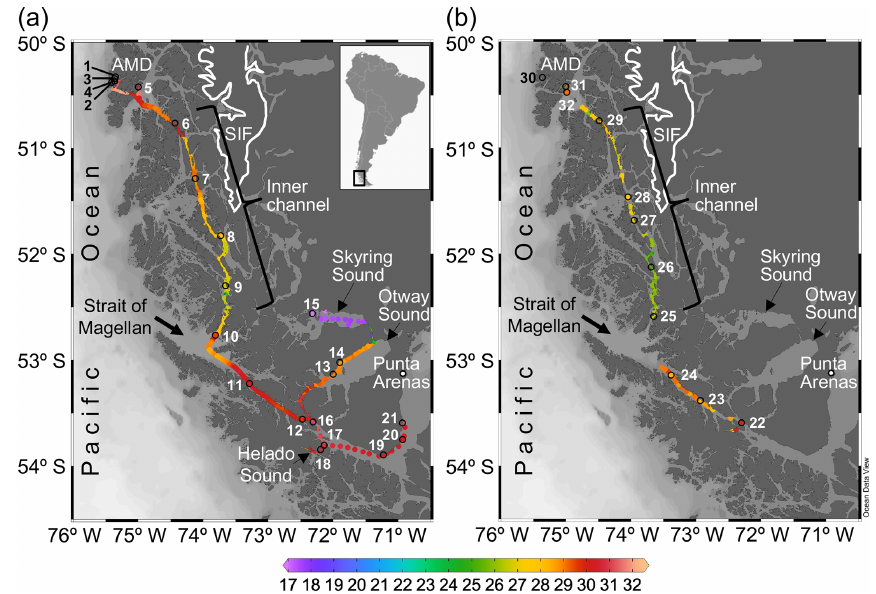
Figure 1. Maps of southern Patagonia showing the study sites and stations sampled during the austral late spring 2015 (a) and early spring 2017 (b) . Salinity recorded at the surface during the two cruises is plotted. The approximate perimeter of the Southern Ice Fields (SIF) is depicted. A zoom into the Archipelago Madre de Dios (AMD) zone with salinity and (cid:127) calcite surface values recorded in 2015 is provided in Fig. S1. Maps were produced by Ocean Data View (Schlitzer,